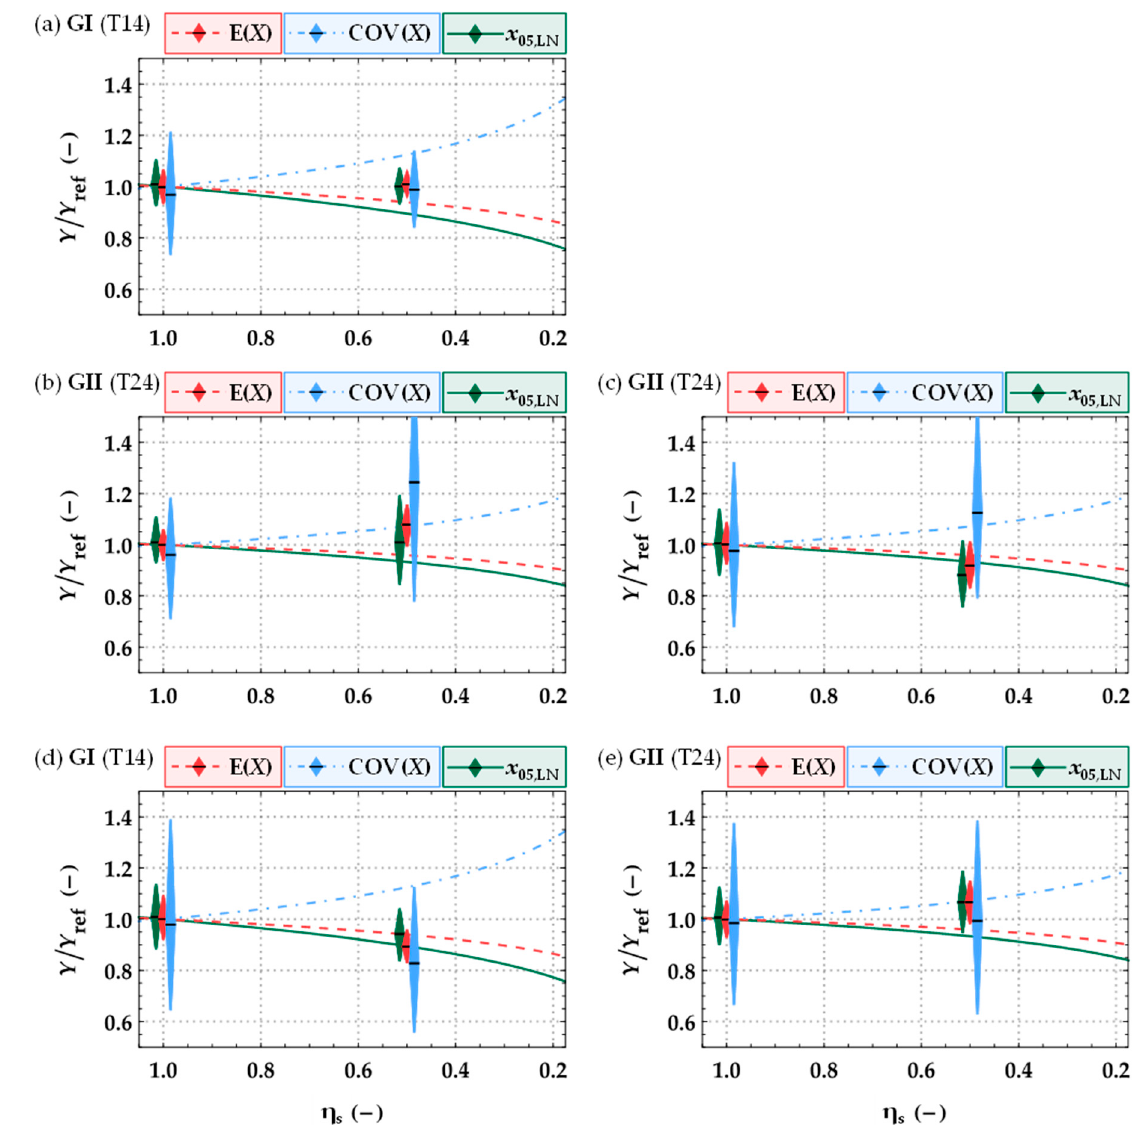
Figure 24. Main statistics Y = {E( X ); COV( X ); x 05,LN } of the bending strength from split vs. unsplit glulam beams ( X = f m,g ) based on model predictions (dashed lines; GI or GII) and from test results taken from literature together with 95% CI assuming X ~ LN; ( a ) Kastner et al. [17]—GL24h, 170 × 160|80 × 160 mm 2 (number of tests: 35 full|78 1-cut); ( b ) Crocetti [15]—GL30h, 90 × 180|40 × 180 mm 2 (number of tests: 16 full|# 16 1-cut); ( c ) Cleason [14]—GL28c, 90 × 225|40 × 225 mm 2 (number of tests: 16 full|# 16 1-cut); ( d ) Viguier et al. [16]—GL24h, 170 × 400|80 × 400 mm 2 (number of tests: 16 full|# 16 1-cut); ( e ) Viguier et al. [16]—GL28h, 170 × 400|80 × 400 mm 2 (number of tests: 16 full|# 16 1-cut).